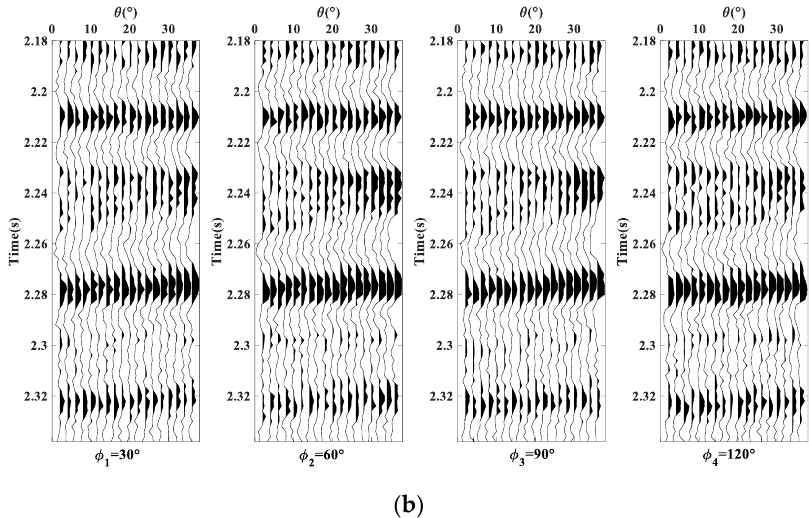
Figure 2. Synthetic azimuthal angle gathers with different levels of noise, where ( a ) shows the case without noise and ( b ) shows the case of SNR = 2.